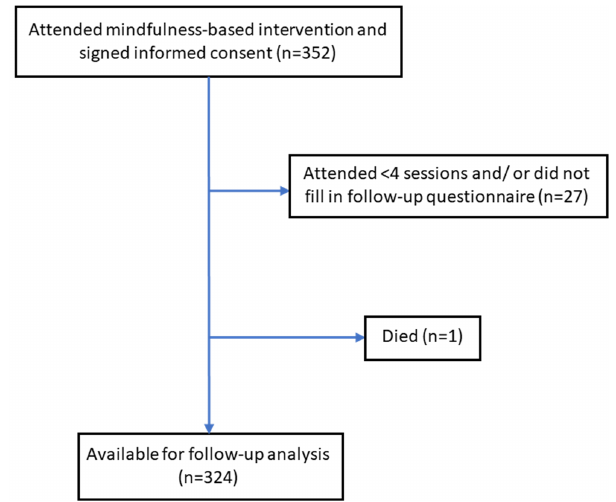
Figure 1. Participant flow chart.